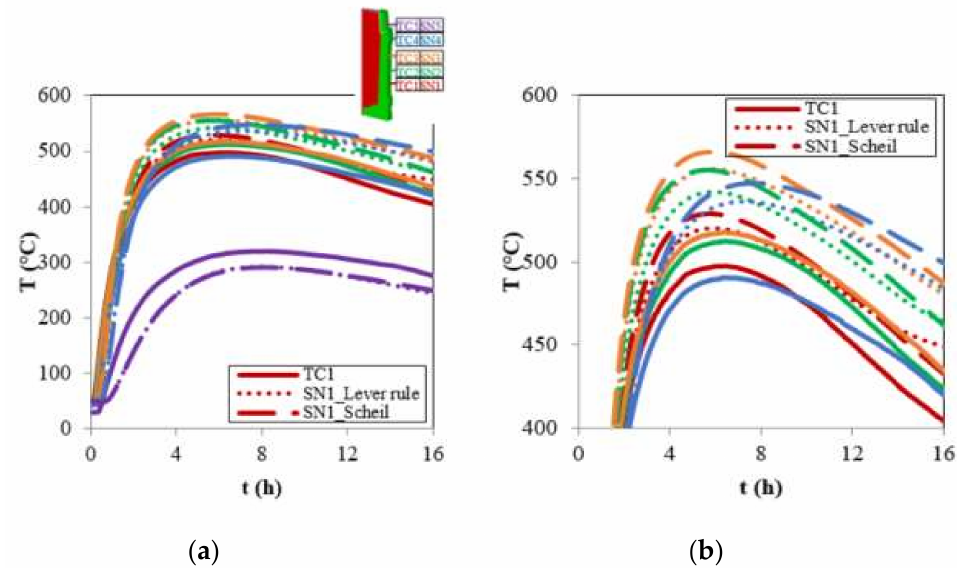
Figure 9. Temperature profiles on 5 specified positions on the outside surface of the mold: ( a ) Temperature profiles for all 5 monitored positions; ( b ) temperature profiles in the higher temperature regions for the first four monitored positions.